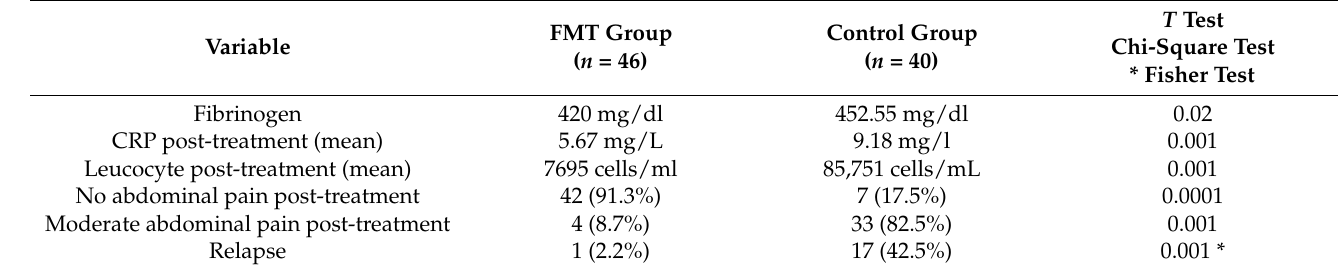
Table 3. Relapse rate, inflammatory markers, and abdominal pain after treatment between study